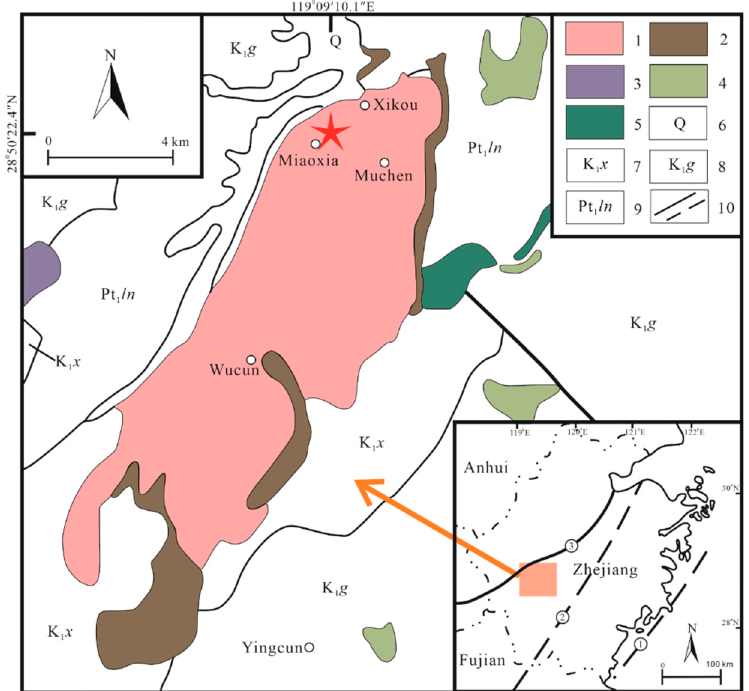
Figure 2. Simplified geological map of Muchen pluton (Modified after Liu et al. [30]). 1. Quartz monzonite; 2. Quartz syenite; 3. Quartz diorite; 4. Granite; 5. Late Yanshanian rhyolite porphyry; 6. Quaternary system; 7. Xishantou Formation; 8. Gaowu Formation; 9.metamorphic rocks of the Longou Group; 10. Faults ( ○ 1 Changle–Nan’ao fault; ○ 2 Zhenghe–Dapu fault; ○ 3 Jiangshan–Shaoxing fault).